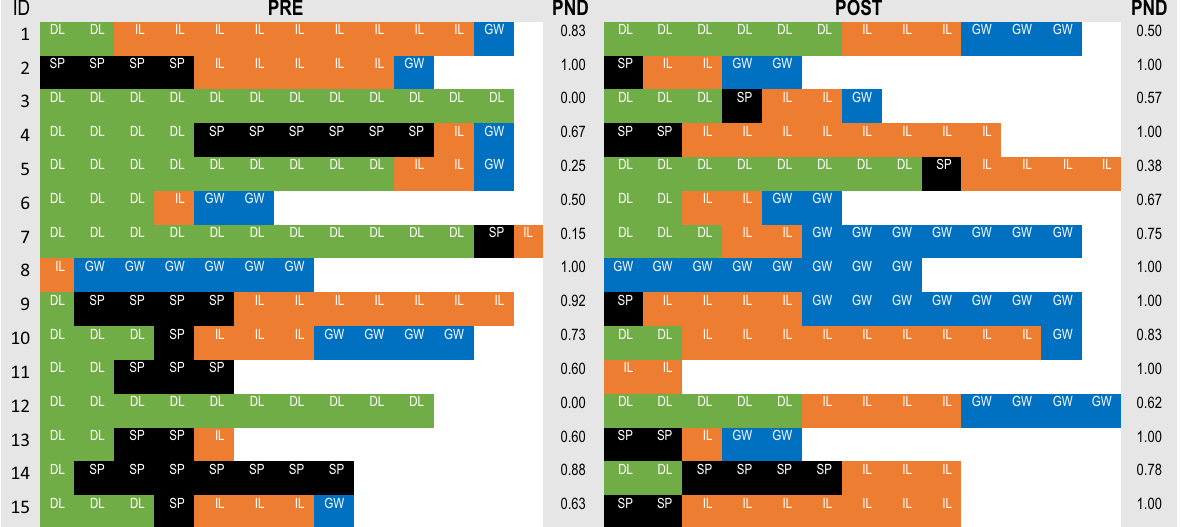
Fig. 8 Pre–Post Class Profiles for 15 Instructors. DL